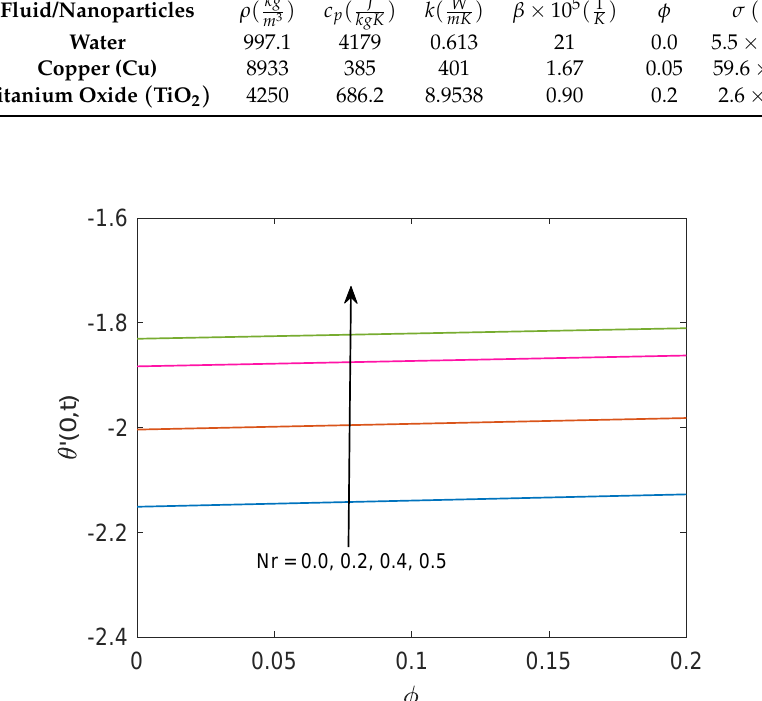
Figure 17. Profile of heat transfer rate for different Nr when Pr = 6.2, Q = 0.5 and t = 0.5.